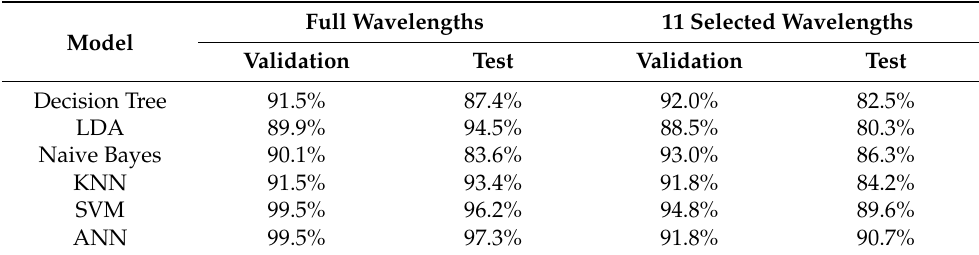
Table 5. The accuracy of each classification model.